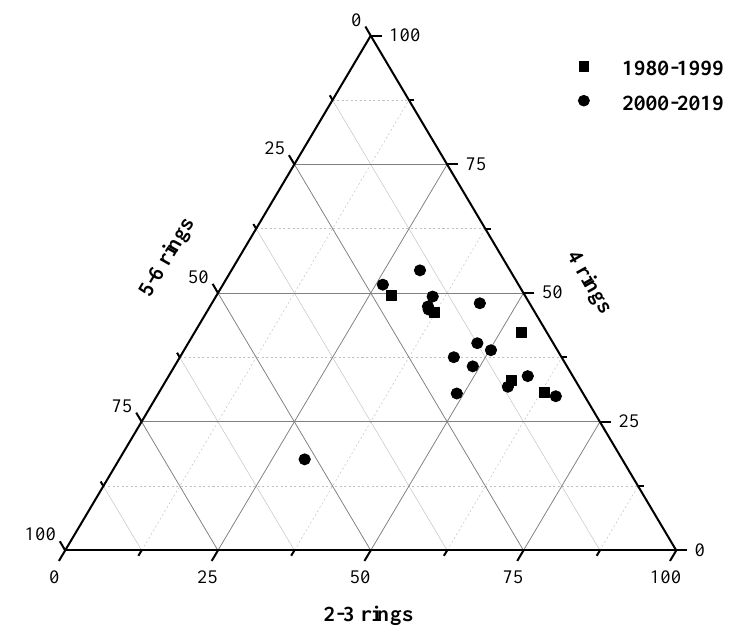
Figure 3. Triangular diagram of percentage concentrations for 16PAHs in soil samples.